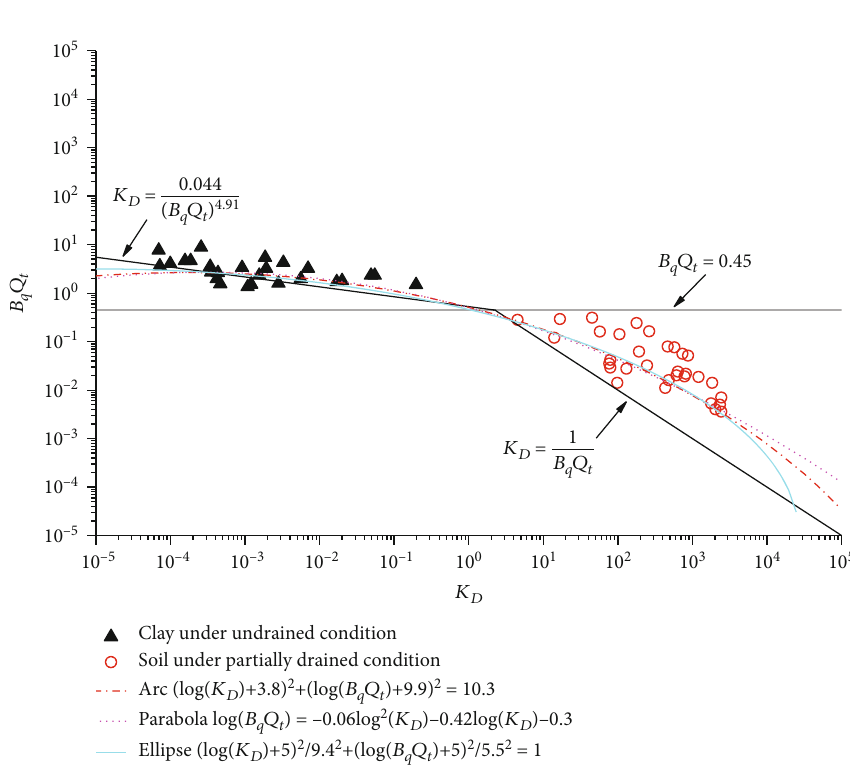
B Q D and q t (data from this ) versus depth tance ( f s ), and pore water pressure ( u 2 recorded at Hongzhuang station in Suzhou, are indicated in Figure 3.